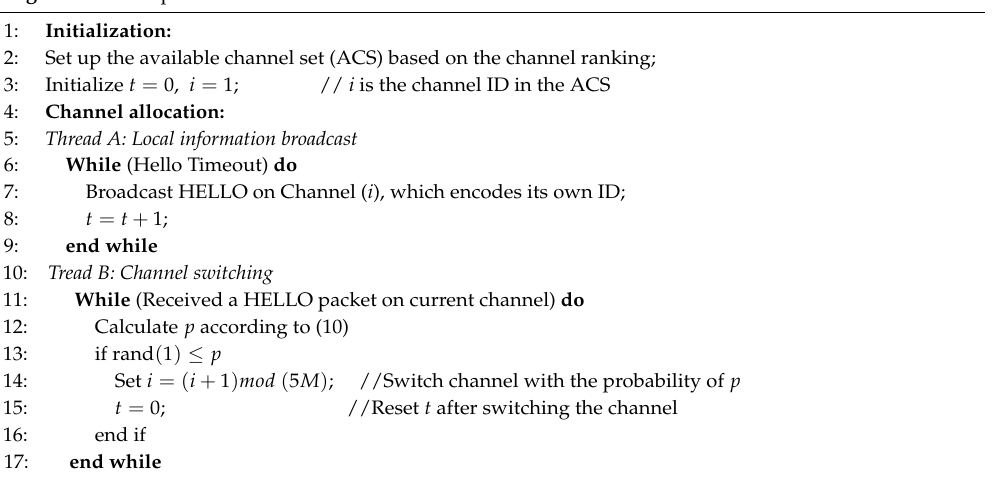
Algorithm 1: Simple distributed channel